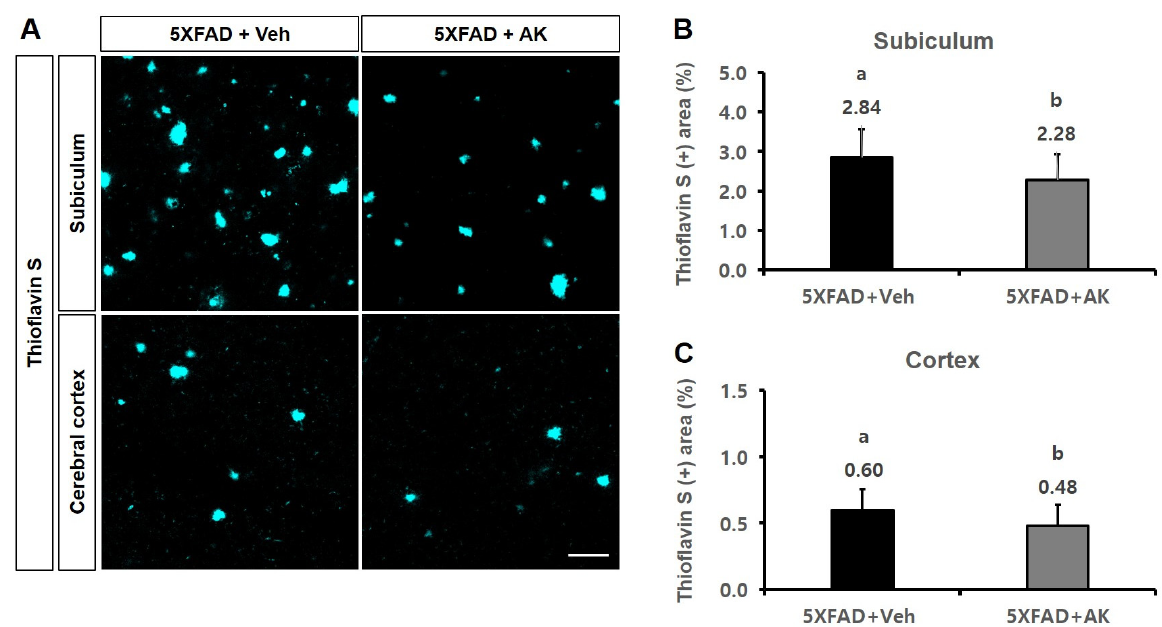
Figure 10. Inhibitory effects of AK extract on the β -amyloid accumulation in the subiculum and deep cortical layer in 5XFAD mice were analysed using the thioflavin S method. ( A ) Photographs of amyloid plaques in brain parts dyed with thioflavin S (TS); ( B ) intensity of the thioflavin S-positive area in the subiculum; ( C ) intensity of the thioflavin S-positive area in the cortex. Scale bar = 50 µm. 5XFAD + Veh: control group and 5XFAD + AK extract: AK extract group ( n = 5). AK extract 200 mg/kg/day was orally administered for 21 days. Statistical analysis was performed using SAS software. The values indicated with different letters were observed to differ significantly at p < 0.05 by Duncan’s multiple range test.